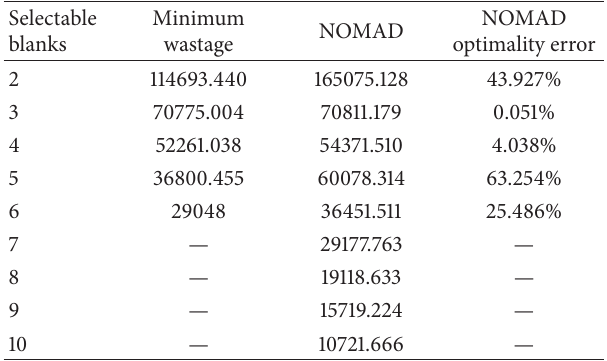
Figure 9: Fraction of nodes pruned due to lower bound 1 (left) and lower bound 2 (right). Table 5: NOMAD solution